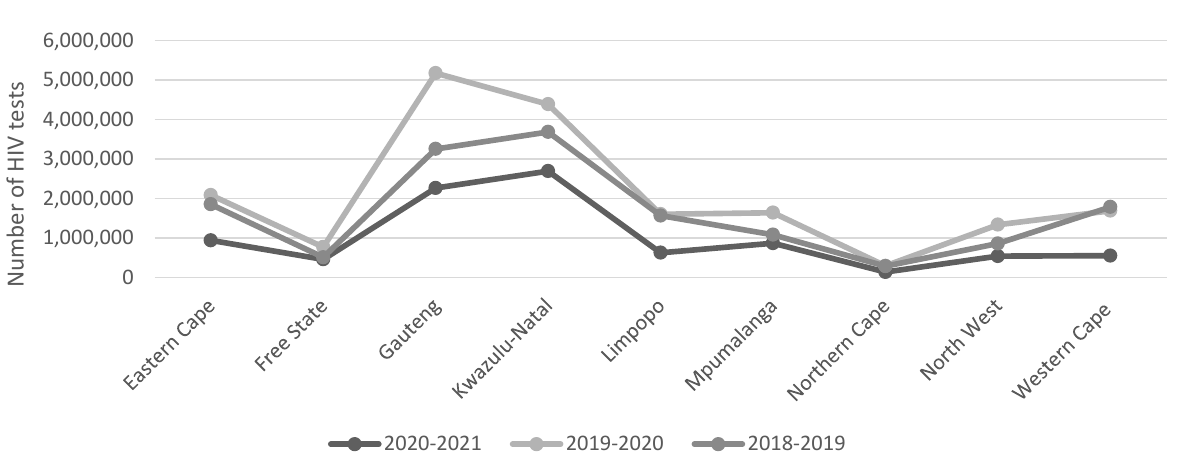
Figure 5. Line graph illustrating the annual number of HIV tests conducted in each province of South Africa, from 2018 until the end of 2020. Data was collected from the National Department of Health website, and represents HIV testing trends in the public health sector [17]. Each point represents the number of HIV tests conducted in the province for that specified year. The trend lines show that between 2018 and 2020, HIV testing in every province increased. In contrast, the trend line for 2020 – 2021 fell much lower than previous years. No significant change in HIV testing can be seen for Free State and the North West, however, Gauteng experienced the most drastic decline between 2019 – 2020 and 2020 – 2021.